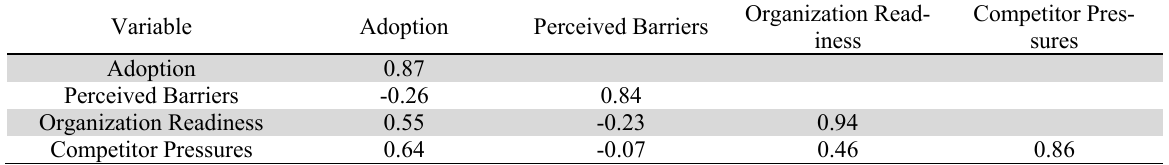
Discriminant Validity for Medium SMEs